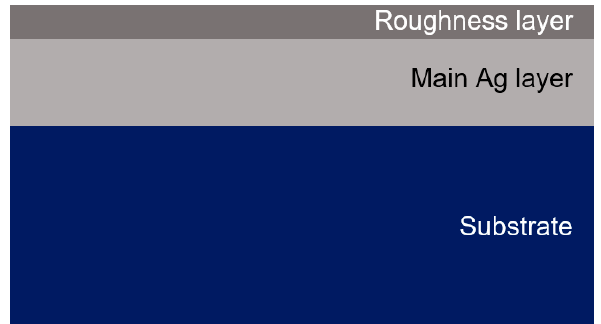
Figure 7. Thin film array at degradation process (model for ε ’’ calculation).